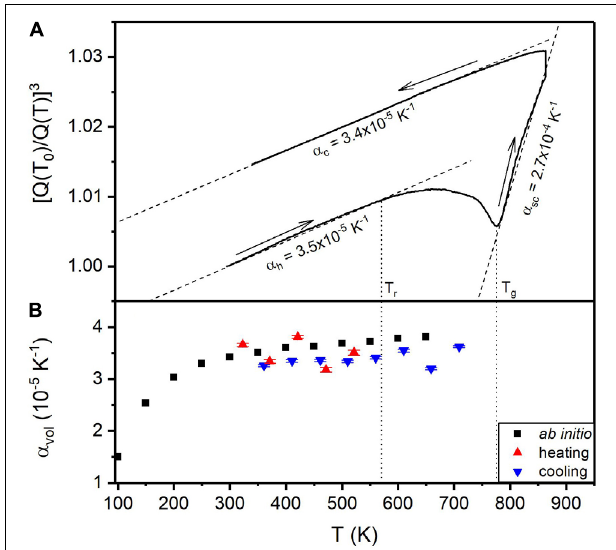
FIGURE 6 | Shift of the principal peak of the structure factor of Pd 62 . 1 Al 27 . 3 Y 4 . 2 Ni 6 . 4 (A) , an indicator of volume expansion. (B) Coefficient of thermal expansion calculated ab initio by the Debye-Grüneisen model (black) in comparison with experimental values (red and blue). Reproduced from Evertz et al. (2017) under the Creative Commons CC BY